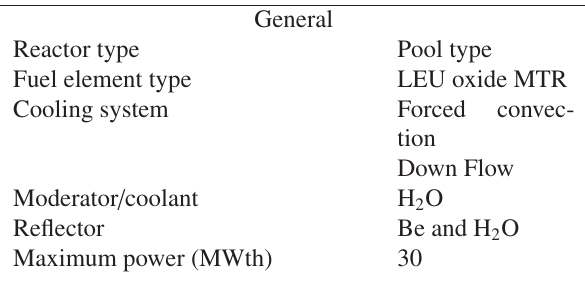
Table 1. Design Parameters of RSG GAS [1]